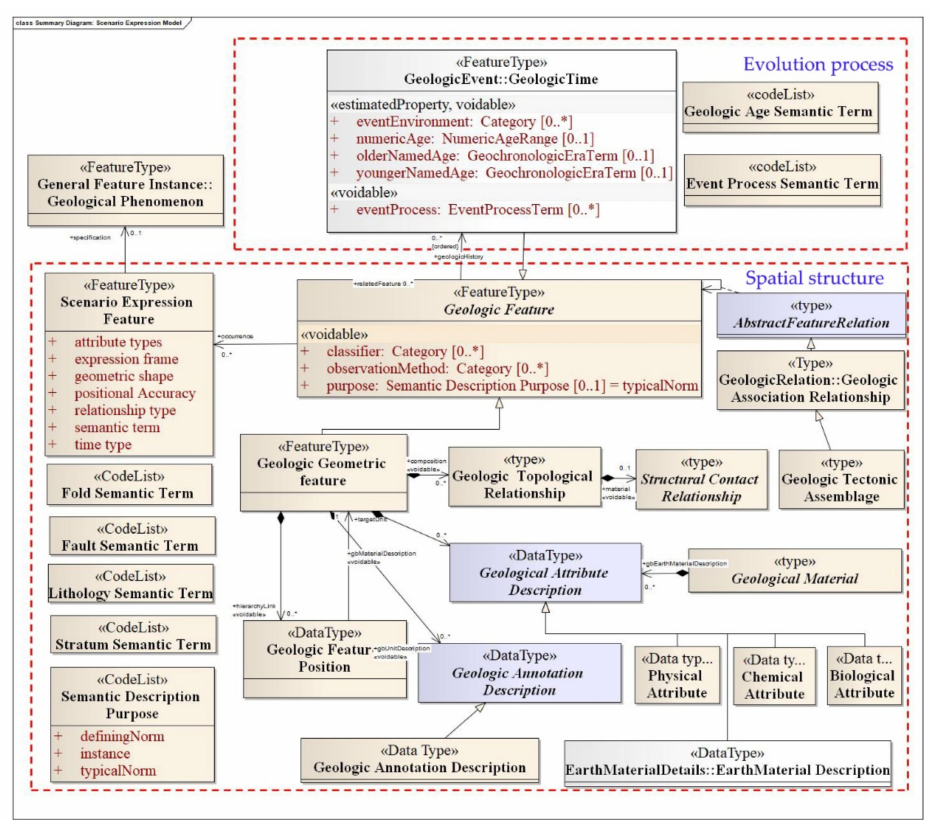
Figure 2. UML design of the regional geological structure scene expression model. The scenario expression feature is based on the geologic features. It has a semantic term, as well as positional accuracy, geometric shape, relationship type, attribute types, and time type operation